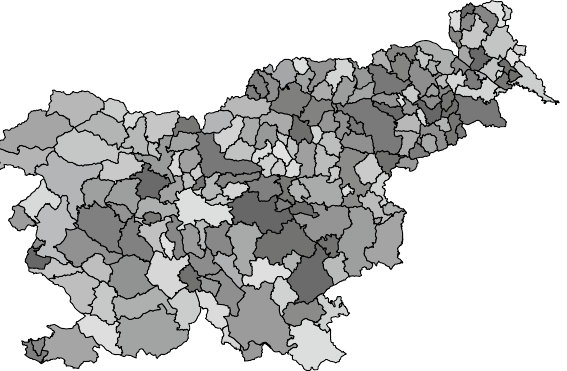
Figure 4. Standardized residuals for an ordinary GLM fit (Poisson regression with offset) to the Slovenia stomach cancer data. Darker gray means larger value. The residuals exhibit substantial, but short-range, positive dependence. Figure created using R version 4.1.2 (https:// www.r- proje ct. org).